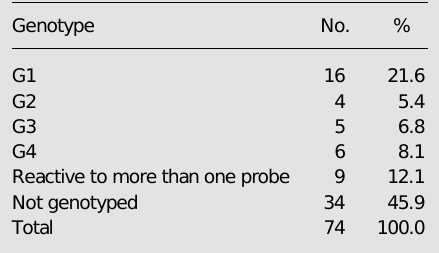
Table 1 - Distribution of rotavirus G genotypes detected by probe hybridization in the State of